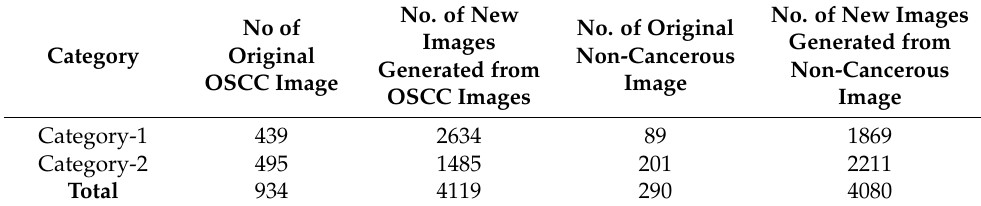
Table 2. Detail of image generation from augmentation